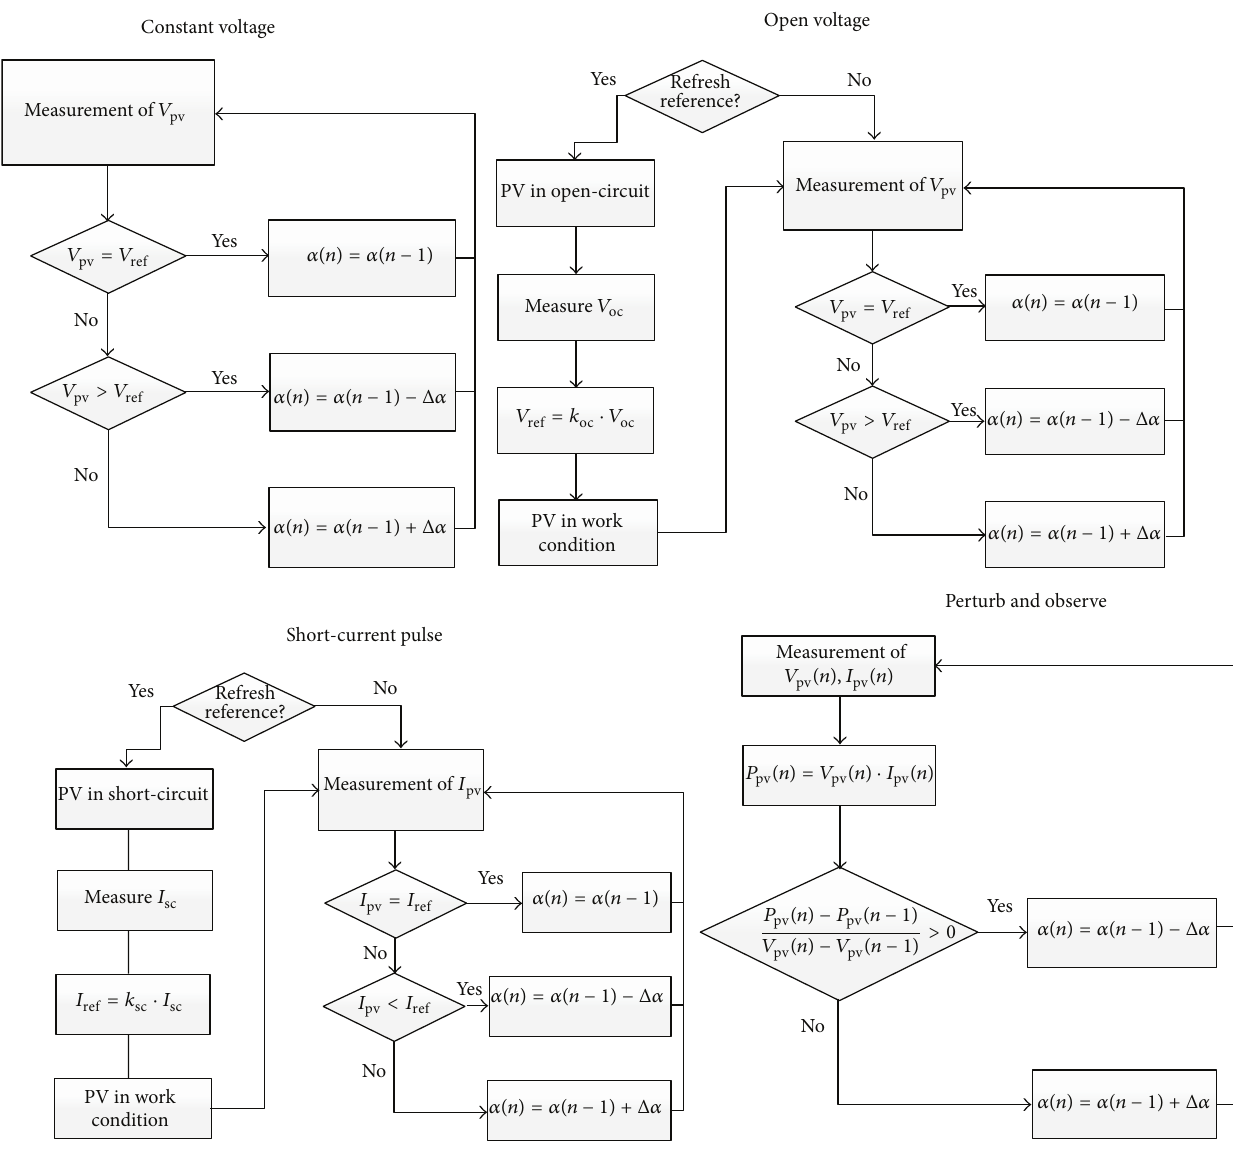
Figure 12: Block-diagrams of the different MPPT used in the present work.